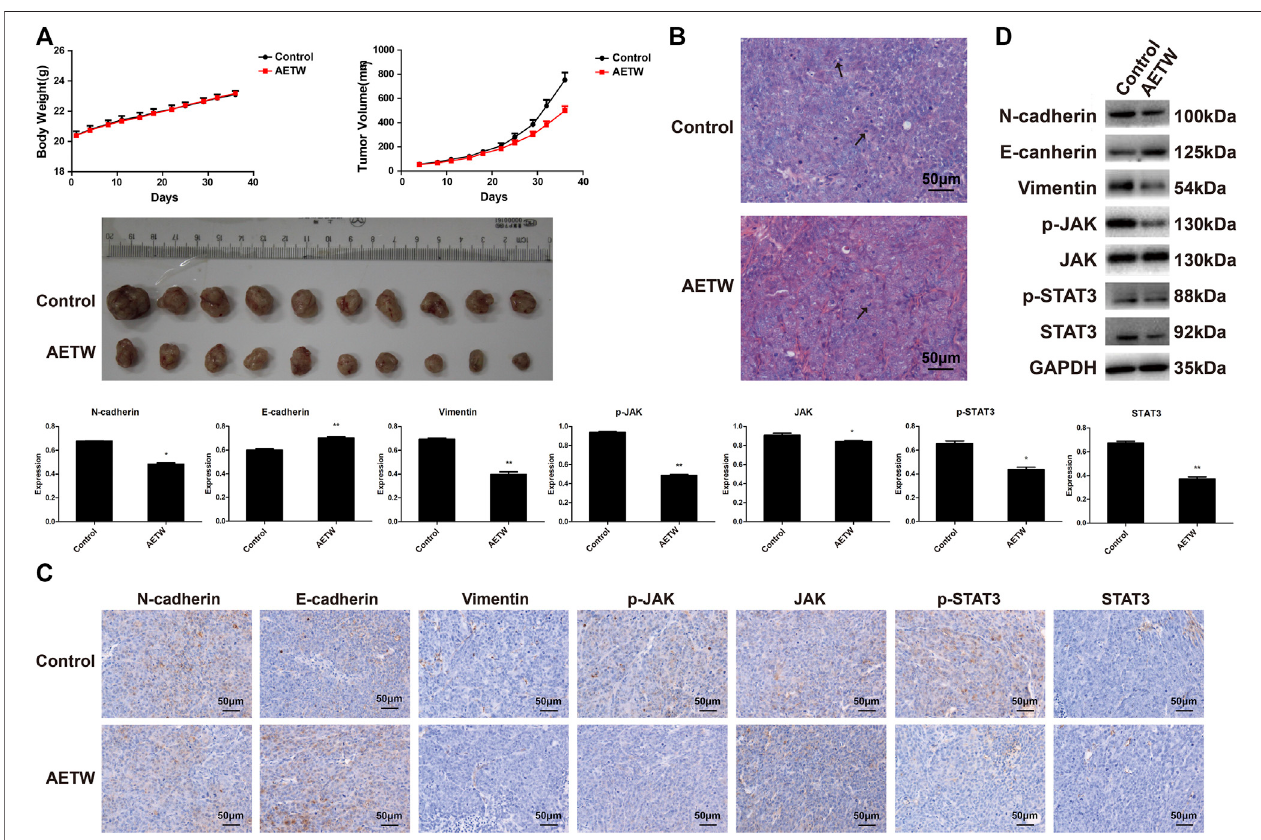
FIGURE7| AETWinhibitedLCcellgrowthandmetastaticability invivo . (A) Measurementsoftumorvolumeandmicebodyweight. (B) Hematoxylin – eosinstaining resultsoftumortissue. (C) ImmunohistochemistryanalysesofEMTmarkersandJAK/STAT3signalingregulators. (D) Westernblotanalysesofexpressionsofcadherins, vimentin, and JAK/STAT3 signaling proteins and their quantitative analyses. Compared with the control group, * p < 0.05, ** p < 0.01.